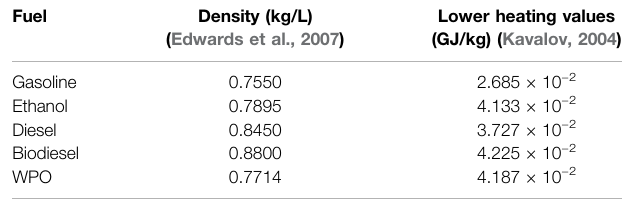
TABLE 1 | Fuel properties for unit